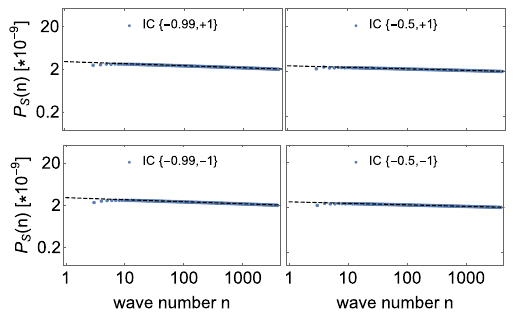
Fig. 6 Primordial scalar power spectrum for different set of back- ground initial conditions, for a Starobinsky potential, and with fluc- tuations initiated after the bounce (blue dots). The standard power law is represented as a dashed black line. The IC for the background are: top left {− 0 . 99 , + 1 } , top right {− 0 . 5 , + 1 } , bottom left {− 0 . 99 , − 1 } , bottom right {− 0 . 5 , − 1 }